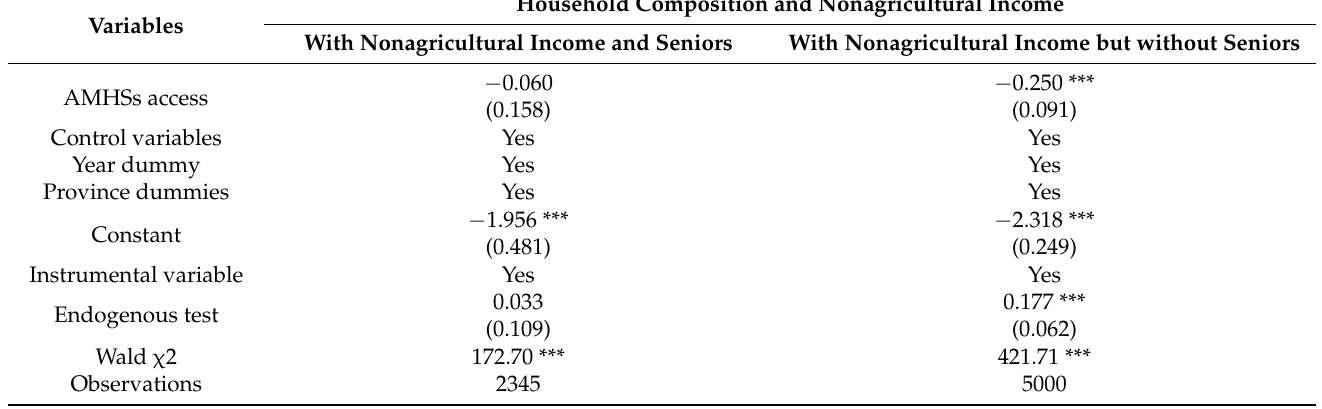
Table A1. Heterogeneity analysis